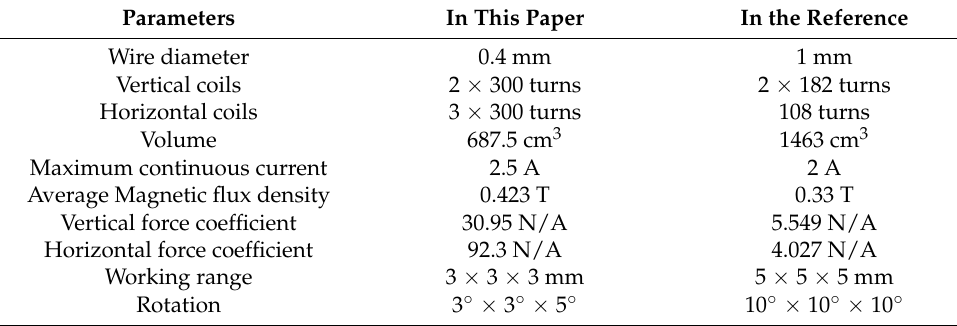
Table 2. Comparison of the parameters of the